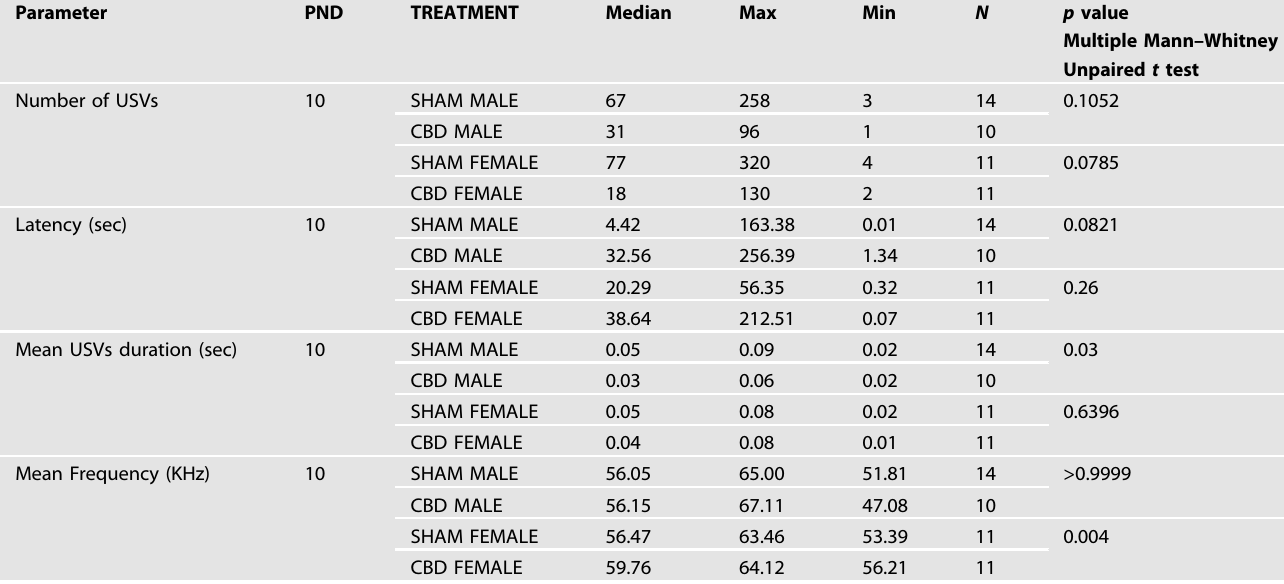
Table 2. Fetal CBD modi fi es the frequency and duration of perinatal USVs.